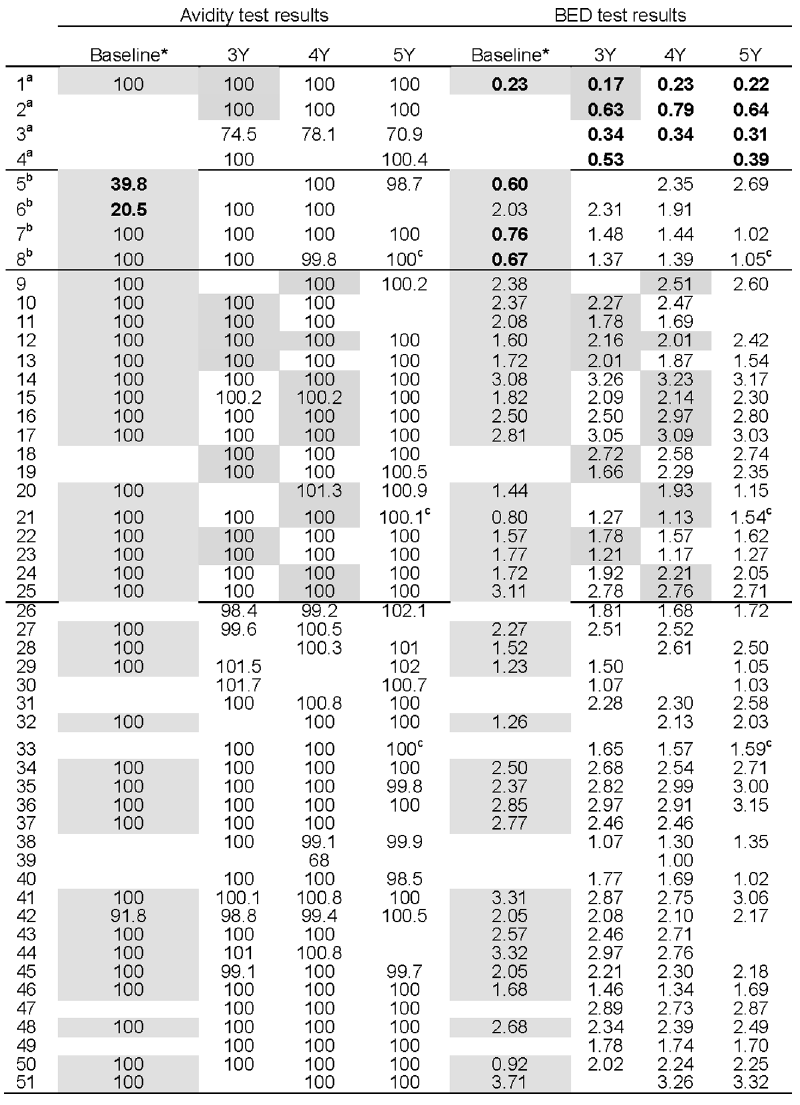
Figure 1. *Longitudinal samples from women in the HIV Prevention Trials Network (HIVNET) 012 trial and HIVNET 012 follow-up study were analyzed using the BED-Capture enzyme immunoassay (BED) [ 8 ] and an antibody avidity assay based on the BioRad 1/2 + O ELISA test (avidity) [ 9 ] . Baseline samples were collected near the time of delivery in the HIVNET 012 trial. Data from the baseline samples is shaded, as well as data from follow-up visits where a woman was pregnant (see Methods). Results from the BED and avidity assays that indicate recent infection (BED: results OD-n , 0.8; for avidity: results , 40%) are shown in bold text. Results are shown for baseline samples (obtained in the HIVNET 012 trial from the time of delivery or 7 days after delivery), and for samples collected 3, 4, and 5 years later (3Y, 4Y, 5Y). a These women were identified as falsely incident at follow-up using the BED assay; two of these women had subtype A infection and two had subtype D infection. b These women may have had incident infection in the HIVNET 012 trial. c These samples were obtained when women were on antiretroviral therapy. pregnant (n =20 results) were different from those obtained when women were not pregnant (n =115, p =0.9, generalized estimat- ing equations model). All but four of the avidity index values, including all values obtained for samples collected when women were pregnant, were in a very narrow range (between 98.4% and 101.7%); four samples collected when women were not pregnant had values between 68.0% and 78.1%. There was no evidence for a difference in avidity test results when women were vs. were not pregnant (p = 0.7, Wilcoxon rank sum). In addition, BED and avidity results were almost exactly the same in longitudinal samples from the 18 women who were pregnant at only one study visit during the follow-up study (p = 0.6, paired t-test).